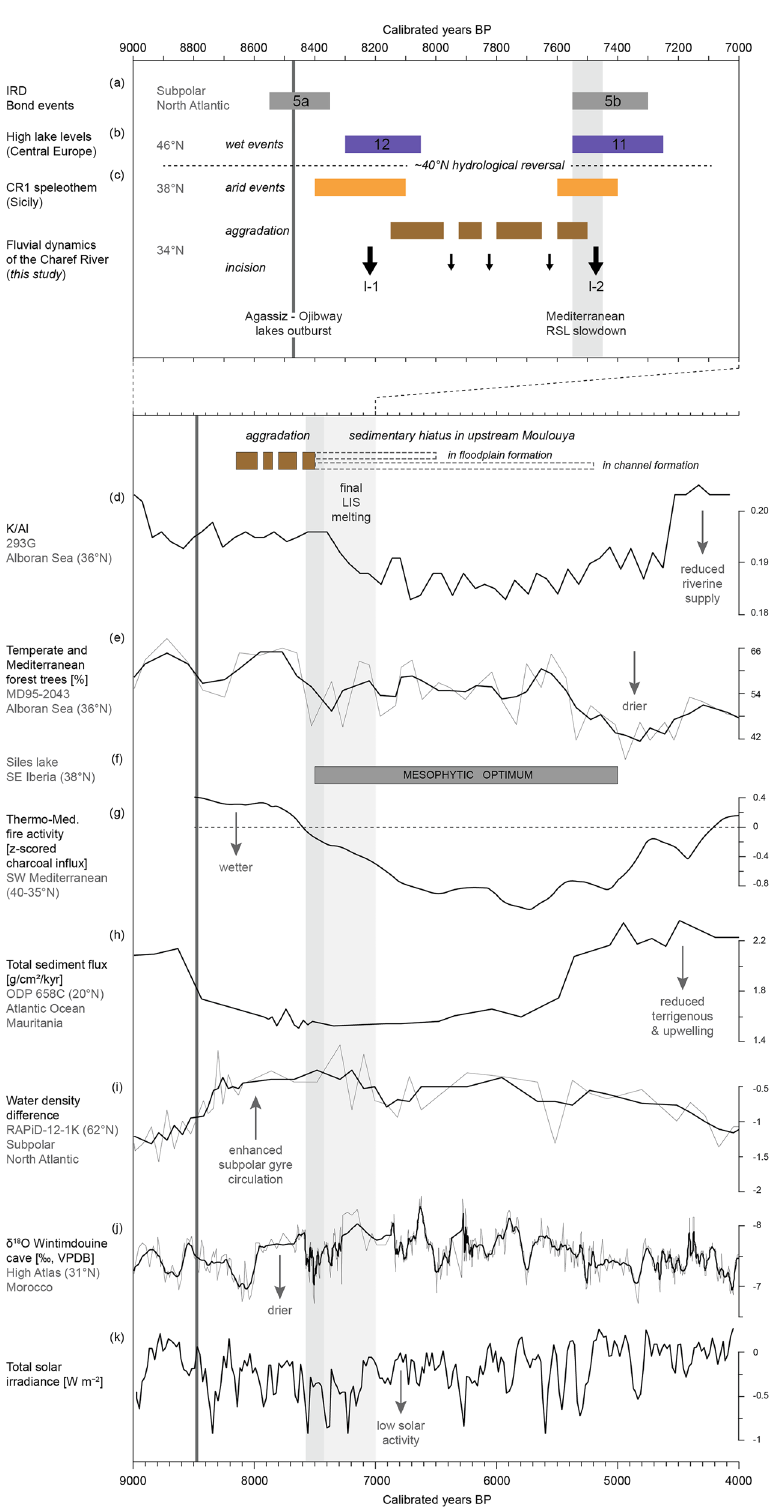
Figure 7. Palaeoenvironmental and palaeoclimatic proxies. (a) Stacked ice-rafted debris events 3 , (b) mid- European high lake levels 38 , (c) δ 18 O depletion from the CR1 speleothem record at the Carburangeli cave in Sicily 13 , (d) K/Al ratio at the 293G site in the Alboran Sea 40 , (e) temperate and Mediterranean forest trees at the MD95-2043 site in the Alboran Sea 11 , (f) mesophytic optimum at the Siles lake in SE Iberia 12 , (g) thermo-Mediterranean fire activity in SW Mediterranean 39 , (h) total sediment flux at the ODP 658C site off Mauritania 46 , (i) water density difference at the RAPID-12-K site in the subpolar North Atlantic 44 , (j) δ 18 O from the speleothem record at the Wintimdouine cave in Morocco 14 , (k) total solar insolation (TSI, W m −2 ) derived from 14 C and 10 Be radionuclides 37